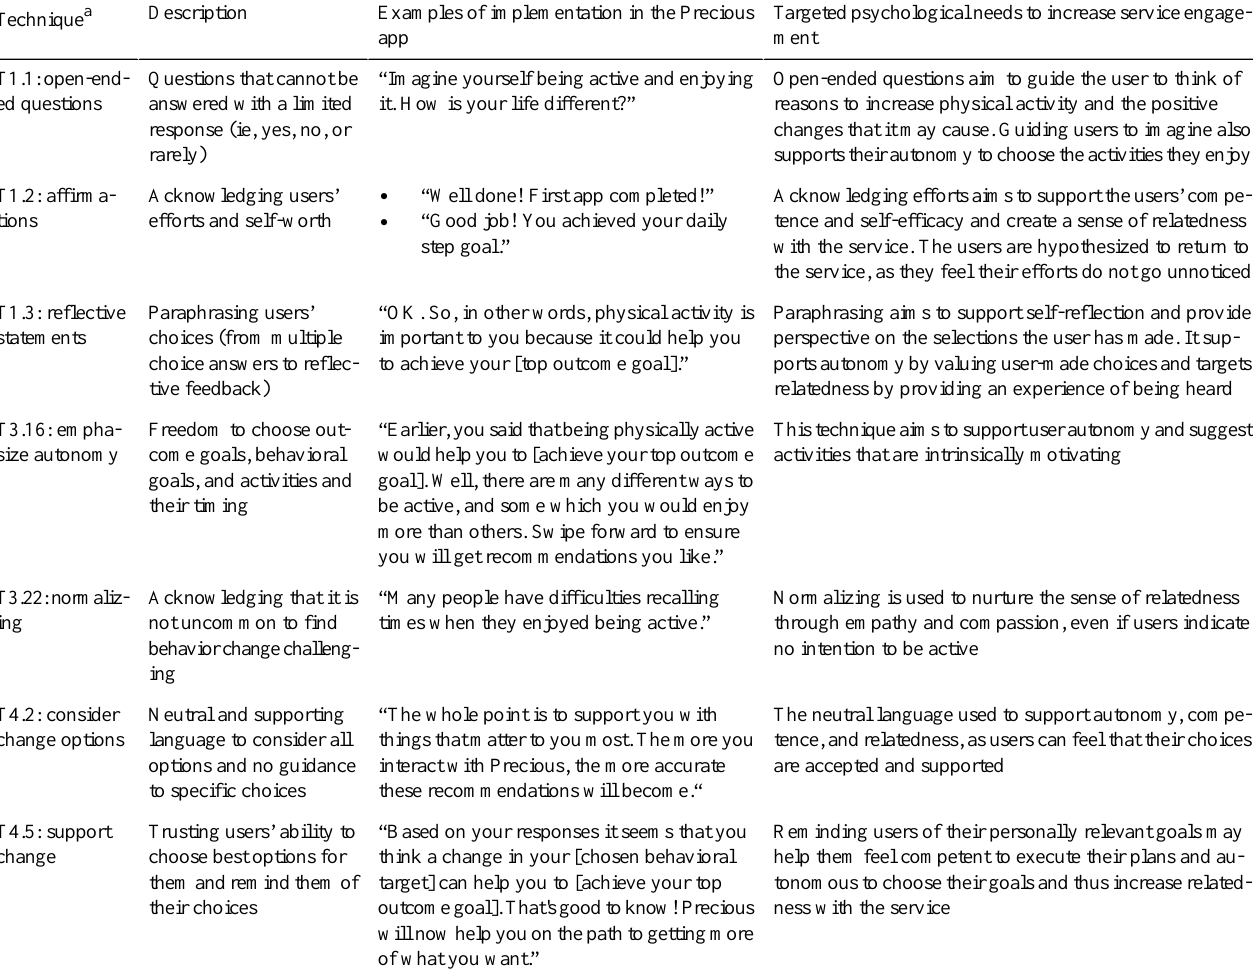
Table 1. Relational techniques from motivational interviewing implemented across the Precious app service (text in square brackets varies based on an individual’s previously indicated preferences or previously made